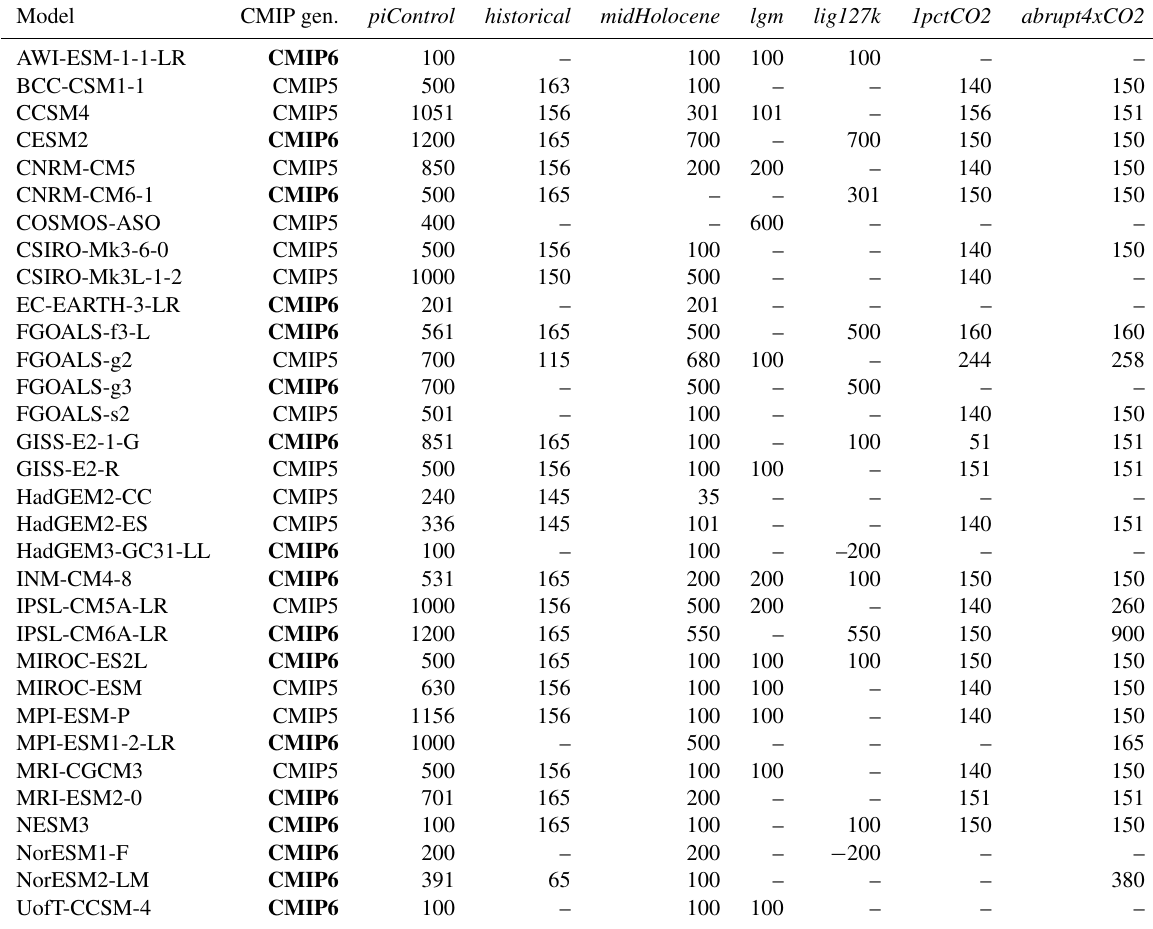
Table 1. List of models included in the study and length of simulations based on the number of years of data available for NINO3.4 in the CVDP archive. Additional information about CMIP6/PMIP4 models (indicated in bold) is provided in the